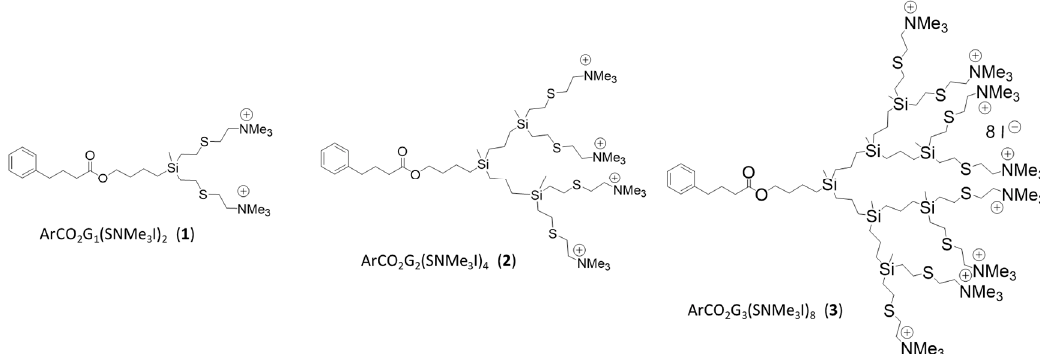
Figure 1. Structures of cationic carbosilane dendrons derived from 4-phenylbutyric acid ArCO 2 G n (SNMe 3 I) m (n = 1; m = 2 ( 1 ), n = 2; m = 4 ( 2 ) and n = 3; m = 8 ( 3 )) n: generation, m: number of functional groups.